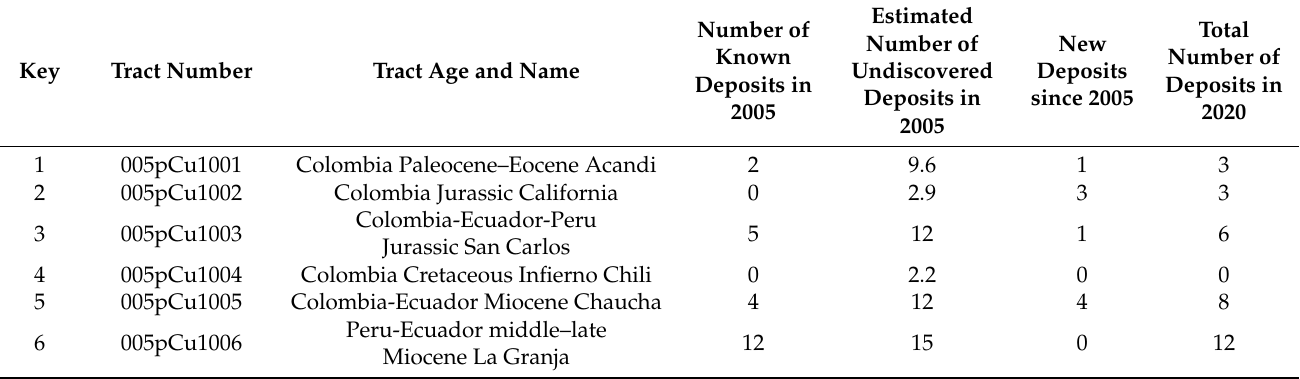
Figure 1. Map of South America showing the Andes region, the permissive tracts for porphyry copper deposits [5] plotted by age, locations of new deposits and prospects as of 2020, those considered in the 2005 assessment, and plate boundaries. Table 1. Number of porphyry copper deposits in the Andes Mountains of South